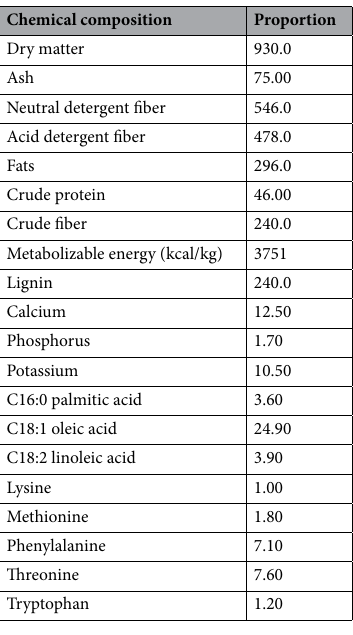
Table 1. Chemical composition (g/kg DM) of olive